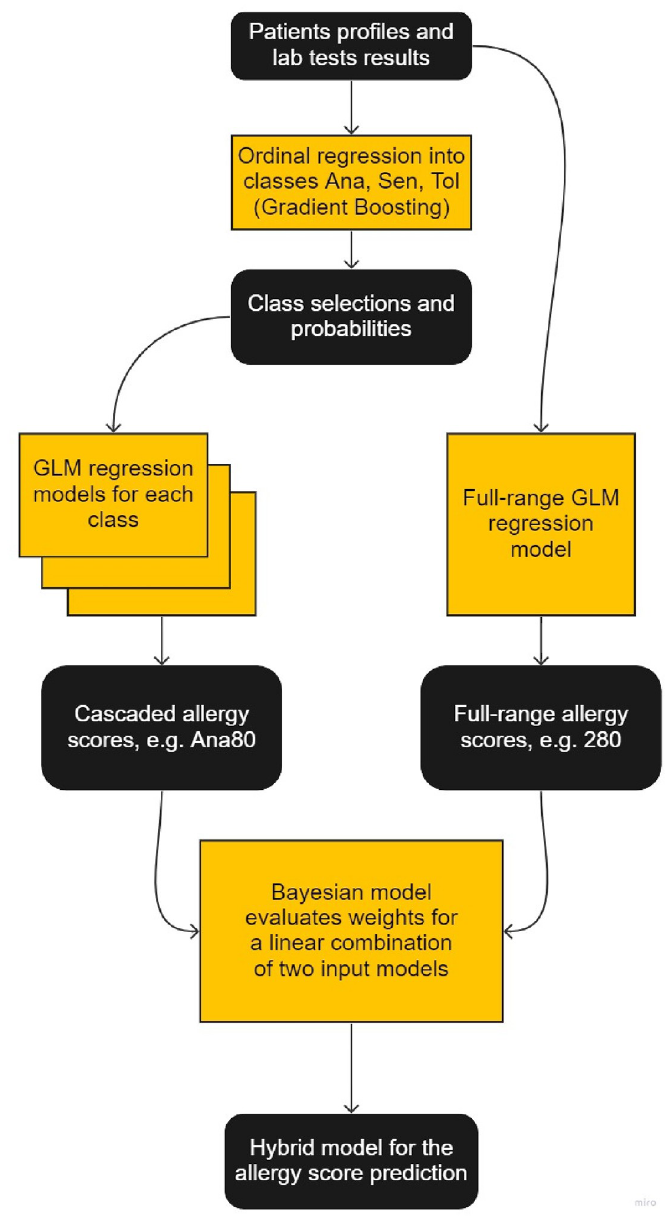
Fig 4. The design of the proposed ML algorithm for prediction of the peanut allergy